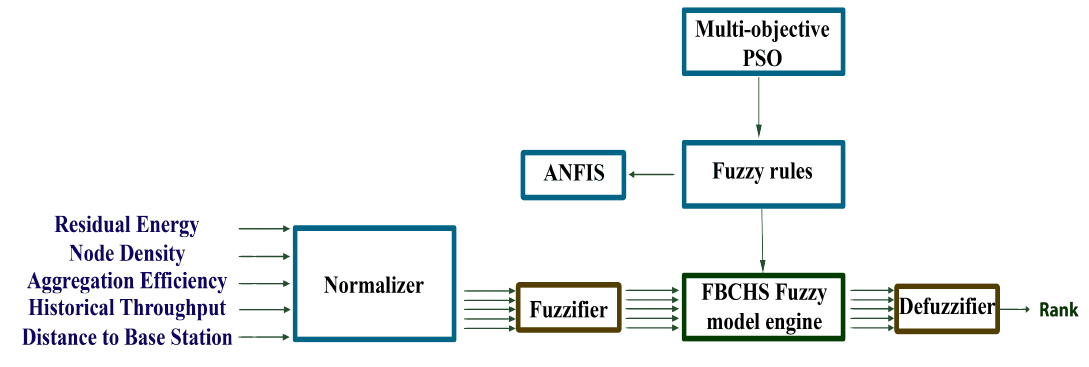
Figure 4. FBCHS fuzzy model for CH selection